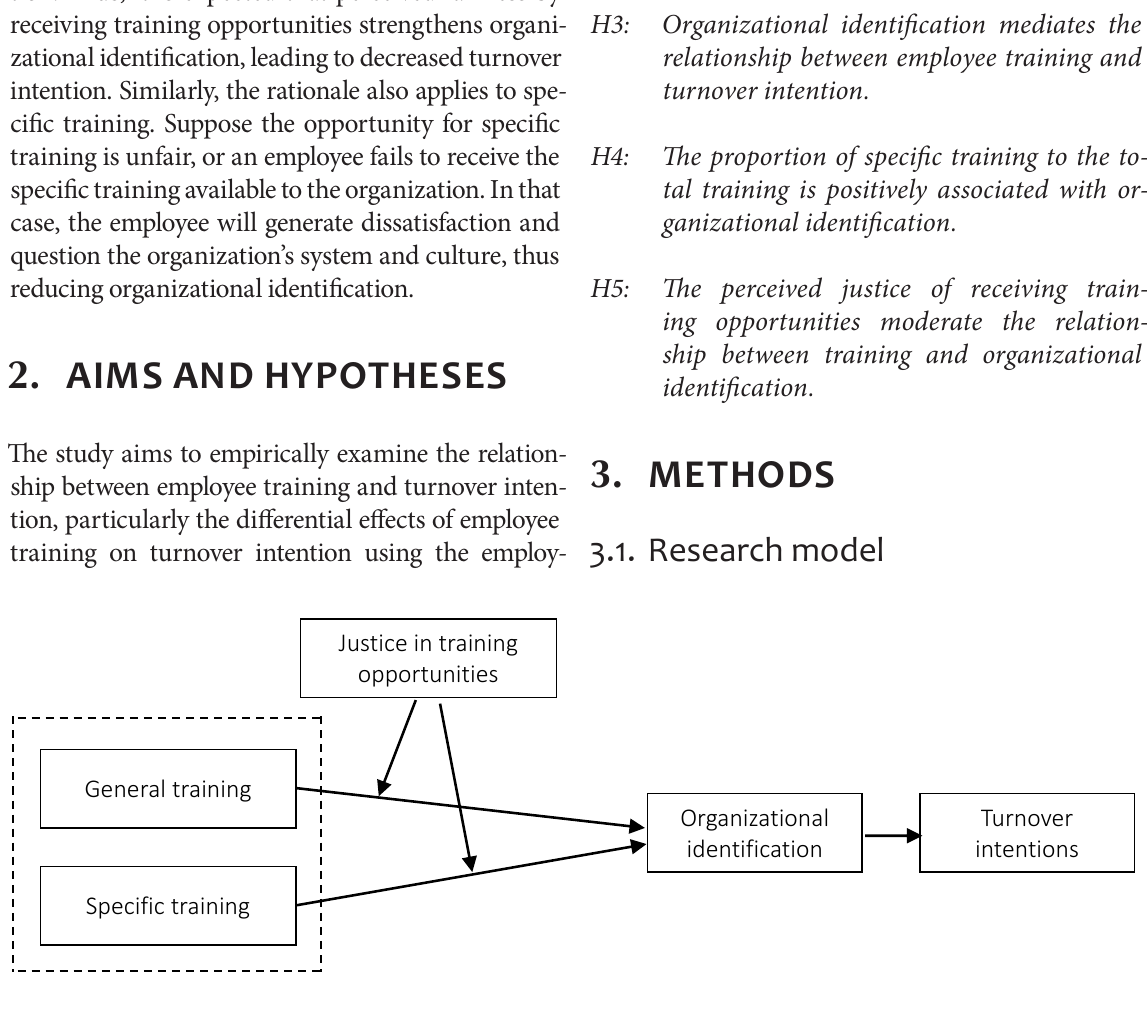
Figure 1. Research